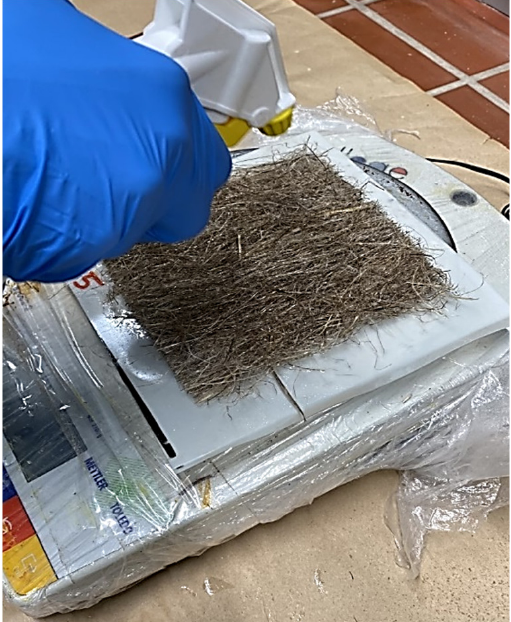
Figure 1. Coating of hemp fiber mats with Palonot fire retardant.